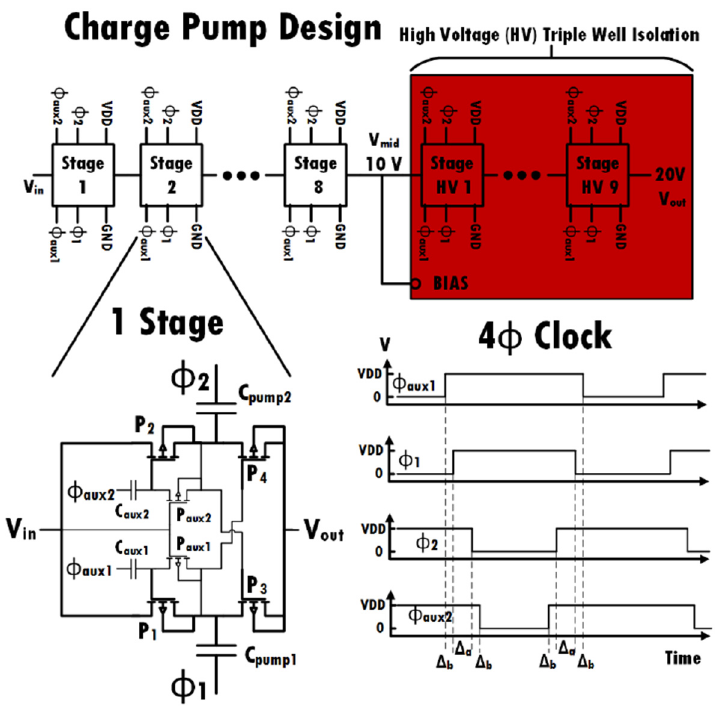
Figure 6. All PMOS charge pump design using high voltage isolation.